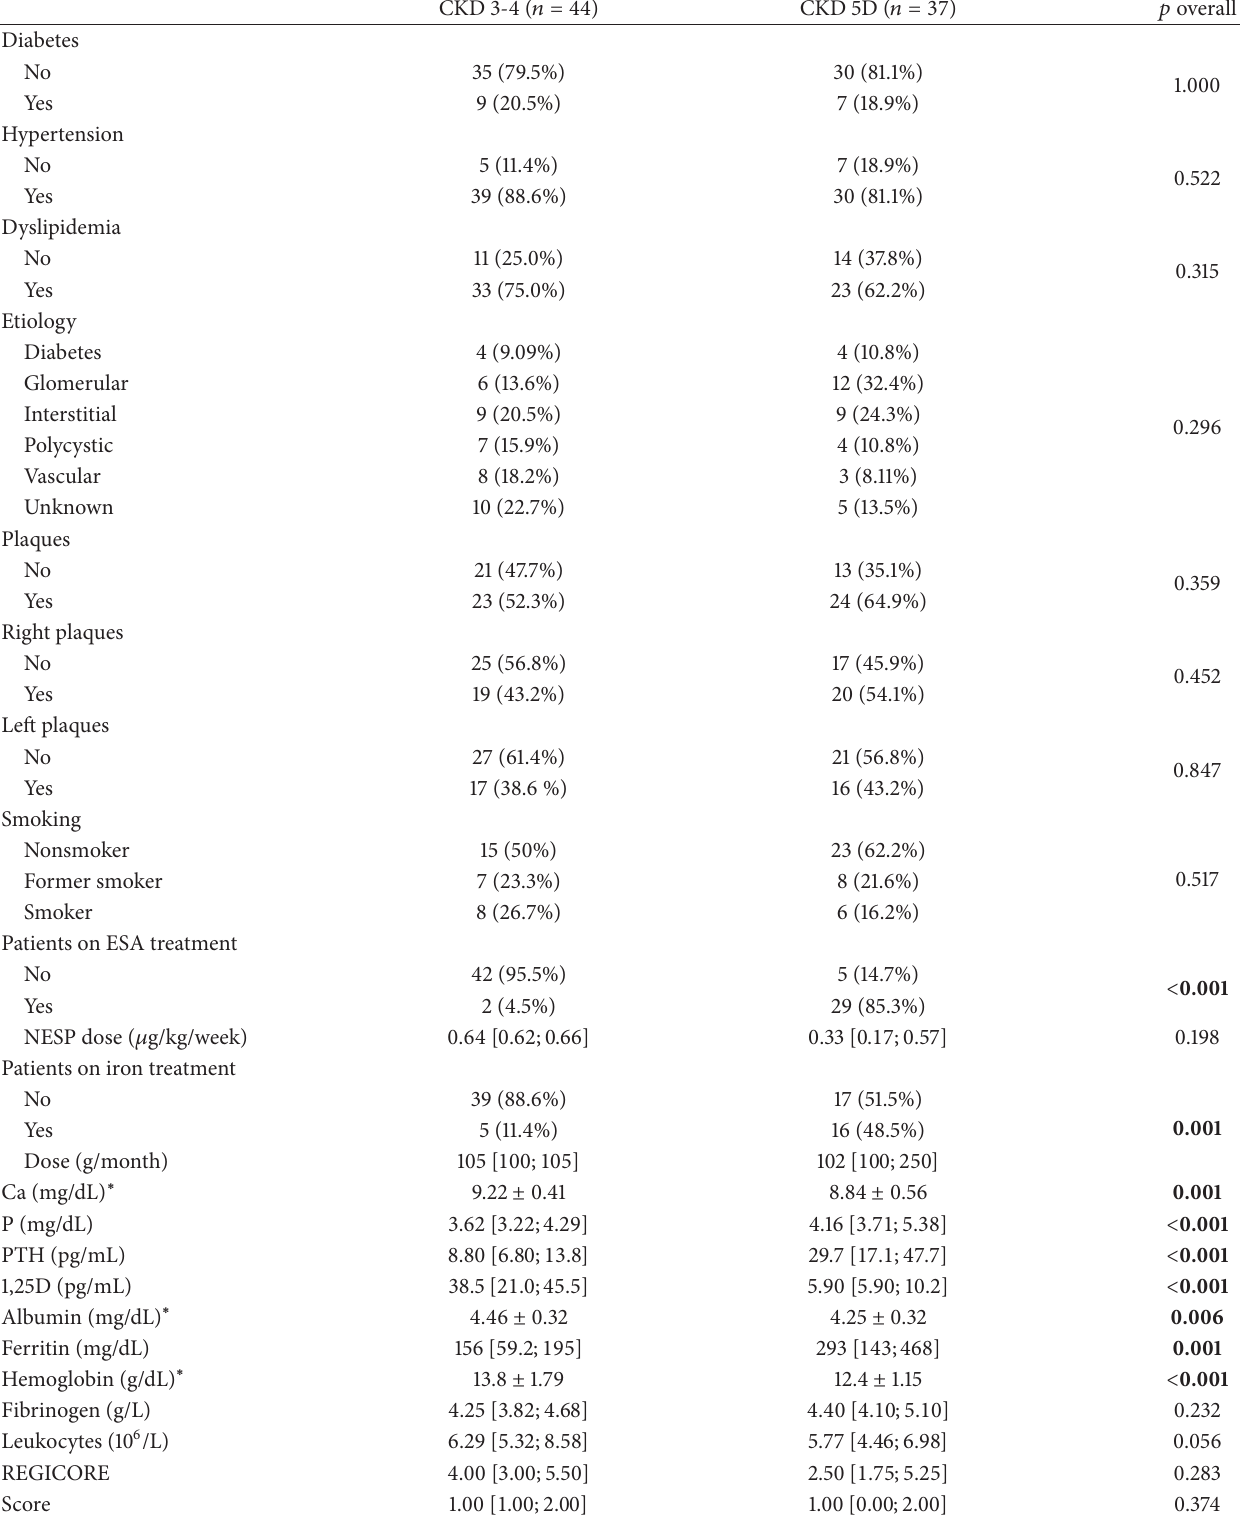
Table 5: Clinical and biochemical differences between nondialysis and dialysis CKD